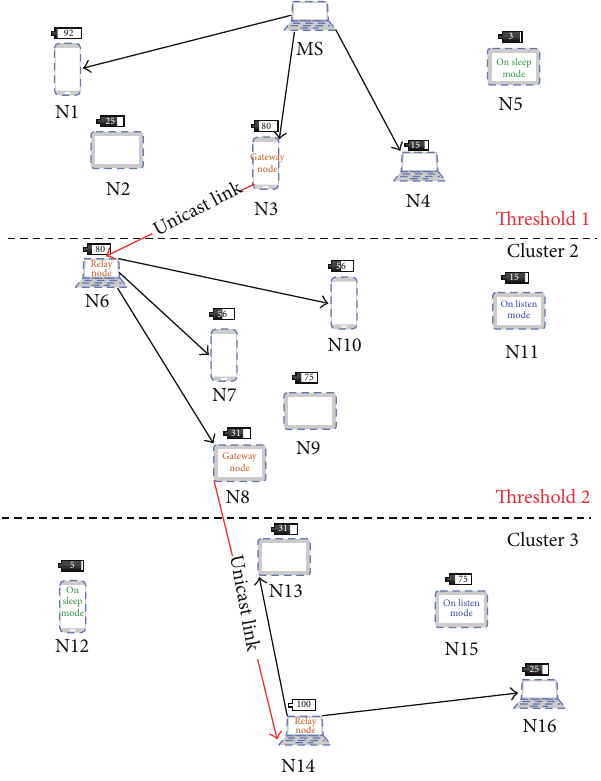
data stream into a number of blocks. In our RMBTM model, all mobile nodes are equipped with a tone-based system that uses short pulses of energy replacing the control packets; this increases the efficiency in MANETs by reducing the excessive usage of control